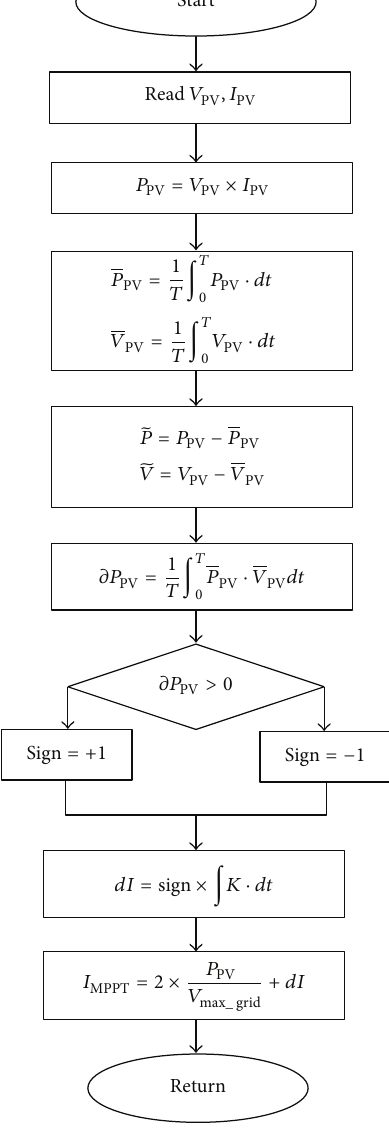
Figure 6: Flowchart of ripple correlation MPPT algorithm.